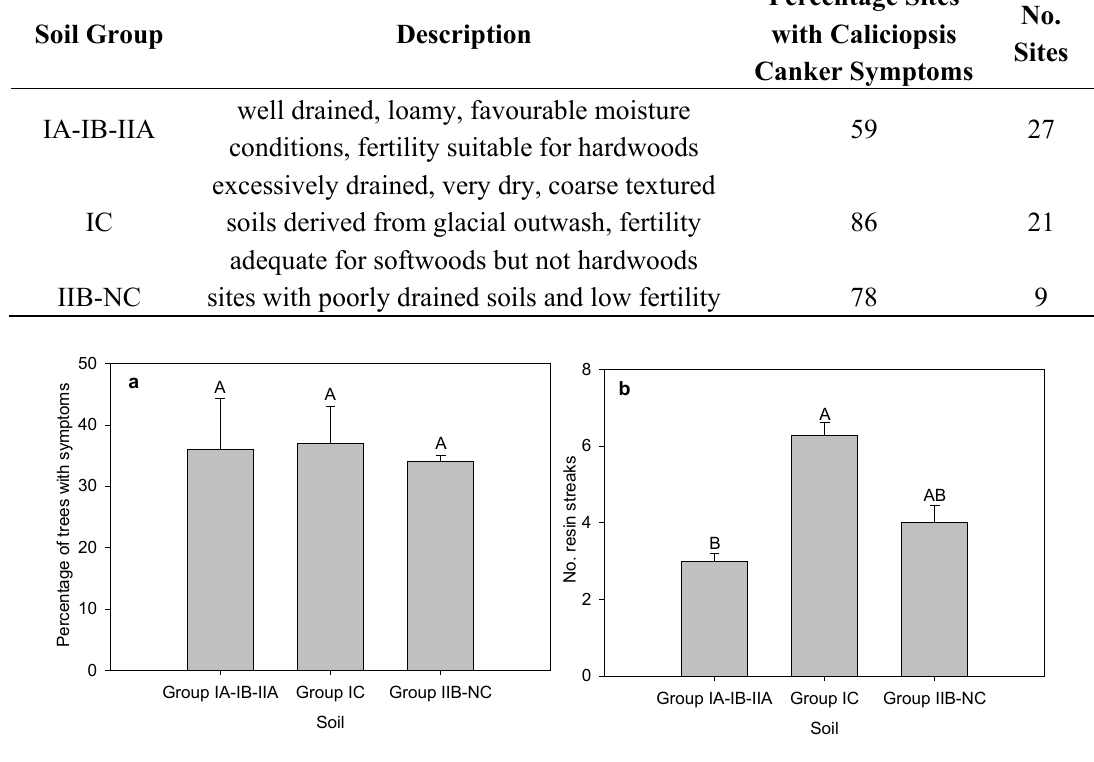
Table 1. Proportion of sites with Caliciopsis canker symptoms across important forest soil groups. Soil Group